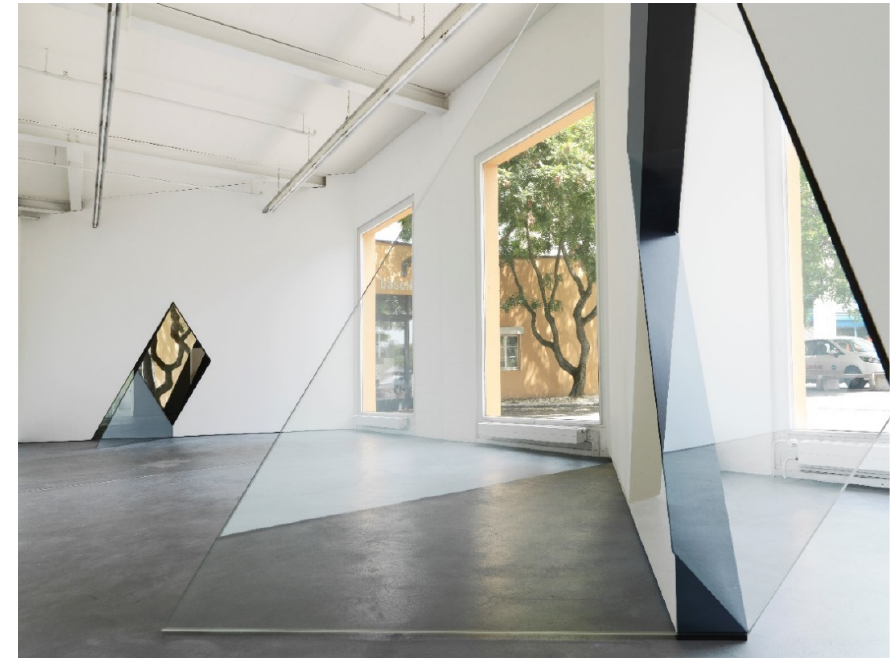
Fig. 15 33-D, 2014 | Aluminum, glass and existing architecture | Total dimensions variable | Location: Kunsthaus Baselland Photo Credit: Serge